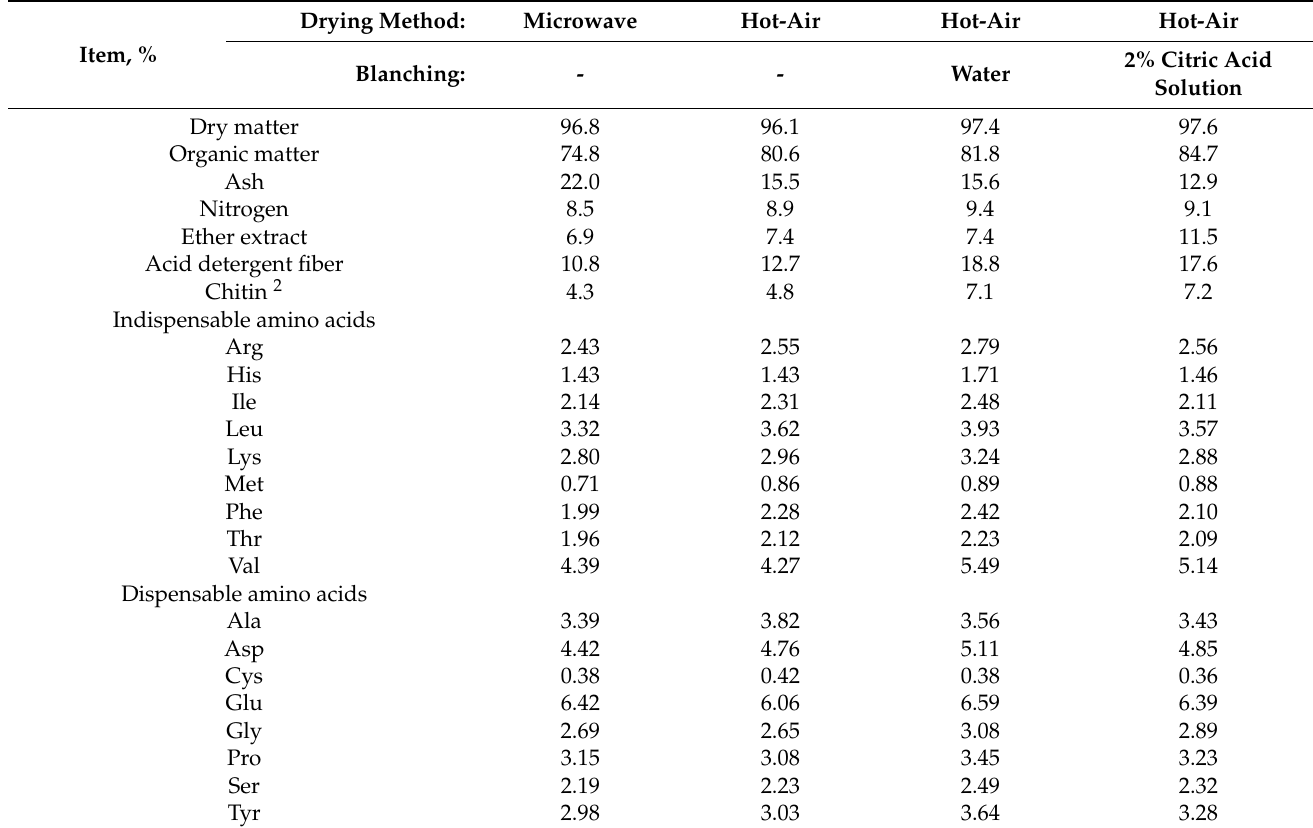
Table 1. Analyzed chemical compositions of four black soldier fly larva meals with various drying and blanching methods, as-is basis 1 .